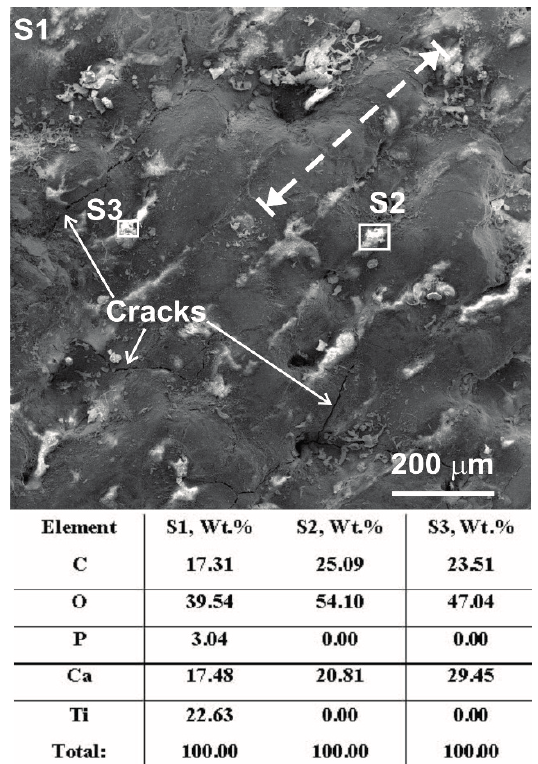
Figure 4. Peculiarities of the laser treated surface (Figure 3a) and EDX data by S1, S2 and S3 areas. Dotted line shows direction of the laser scanning.